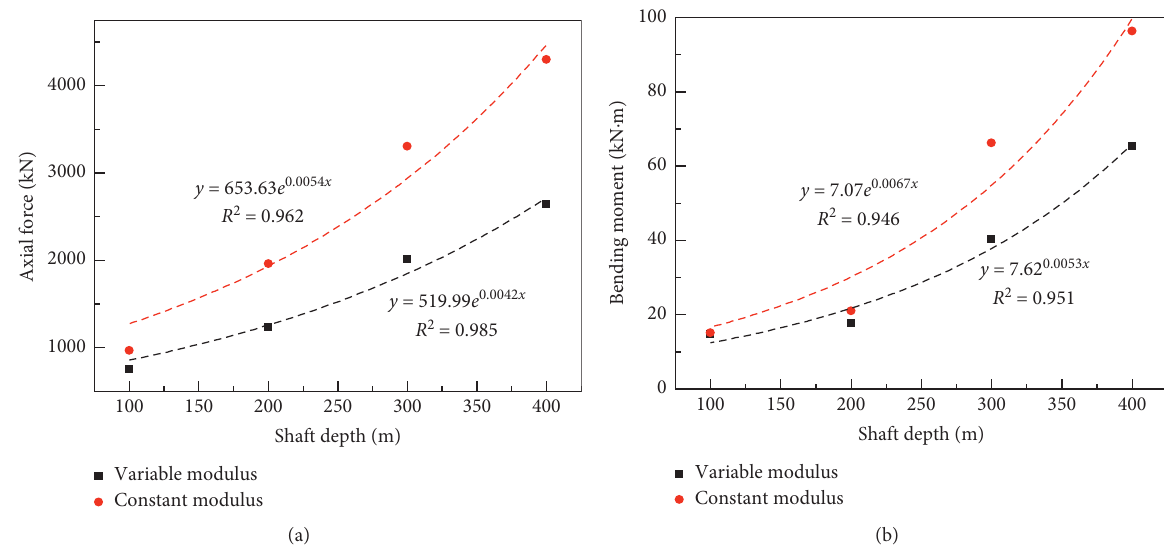
Figure 21: Maximum axial force and maximum bending moment as estimated using different models for liner modulus: (a) axial force in kN and (b) bending moment in kN · m.